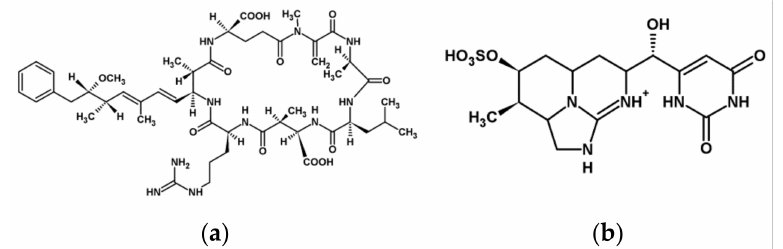
Figure 1. The chemical structure of MC-LR ( a ) and CYN ( b ). While the latter neurotoxic groups affect mainly human and animal tissues and cells, MCs and CYNs, traditionally called hepatotoxins, have a broad spectrum of toxicity since several other organisms (bacteria, fungi, algae, plants) were investigated and toxic consequences were noted